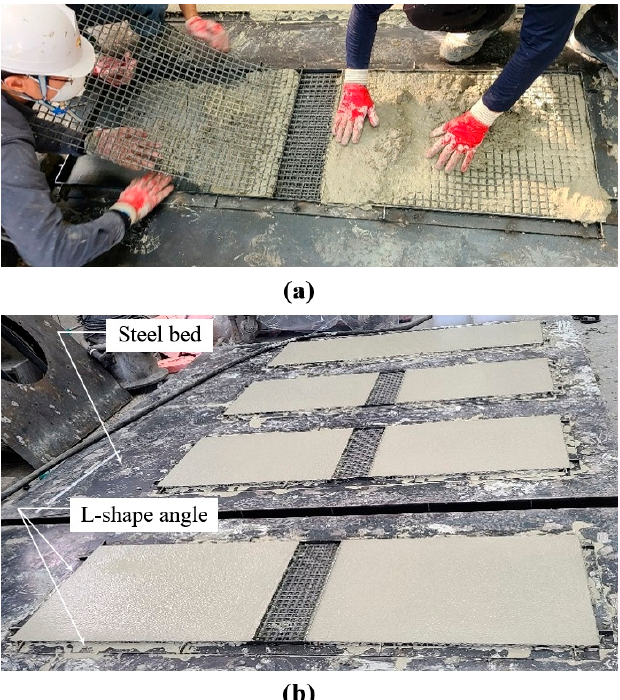
Figure 12. Fabrication of lap-spliced TRC panel: ( a ) installation of textile grid; and ( b ) the placing of mortar.